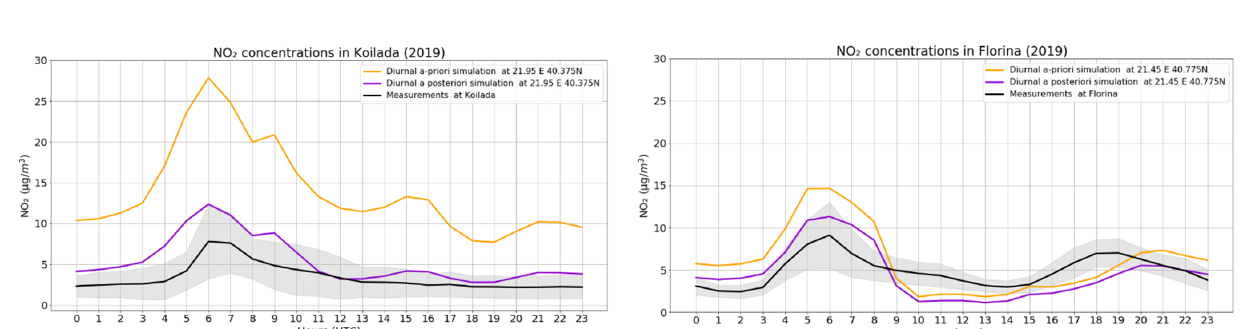
Figure 10. Diurnal variability of the simulated NO 2 surface concentrations using the a priori emissions (orange lines), the a posteriori emissions from the S5P/TROPOMI assimilation (purple lines) and in situ measurements (black lines) of the station Koilada ( left ) and Florina ( right ) for the summer of 2019.